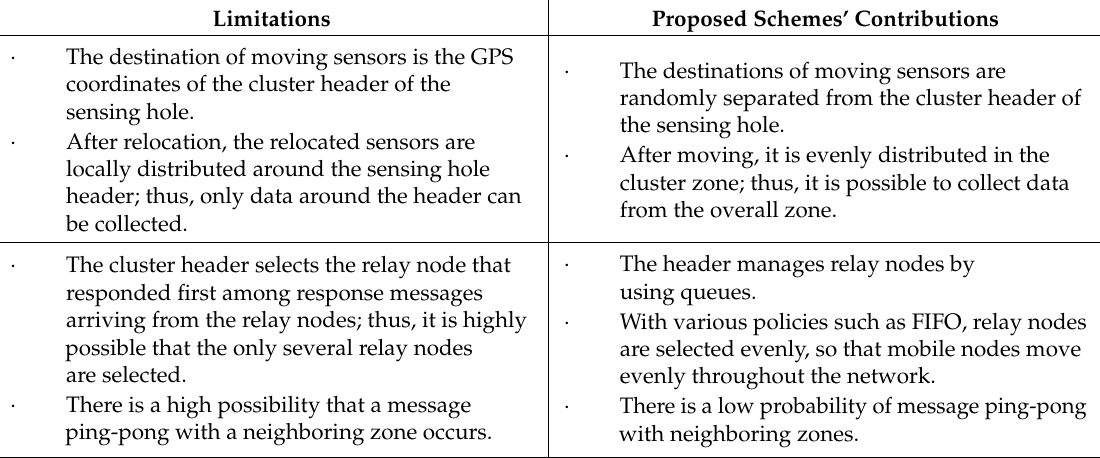
Table 1. Limitations of the previous relocation protocol [25] and contributions of this